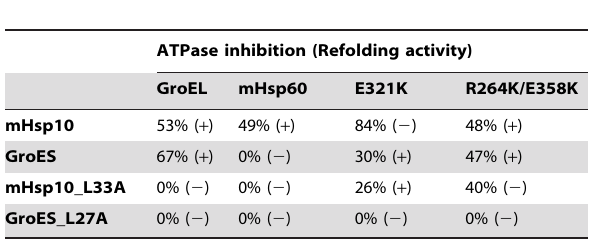
Table 1. Inhibition of chaperonin ATPase activity by various